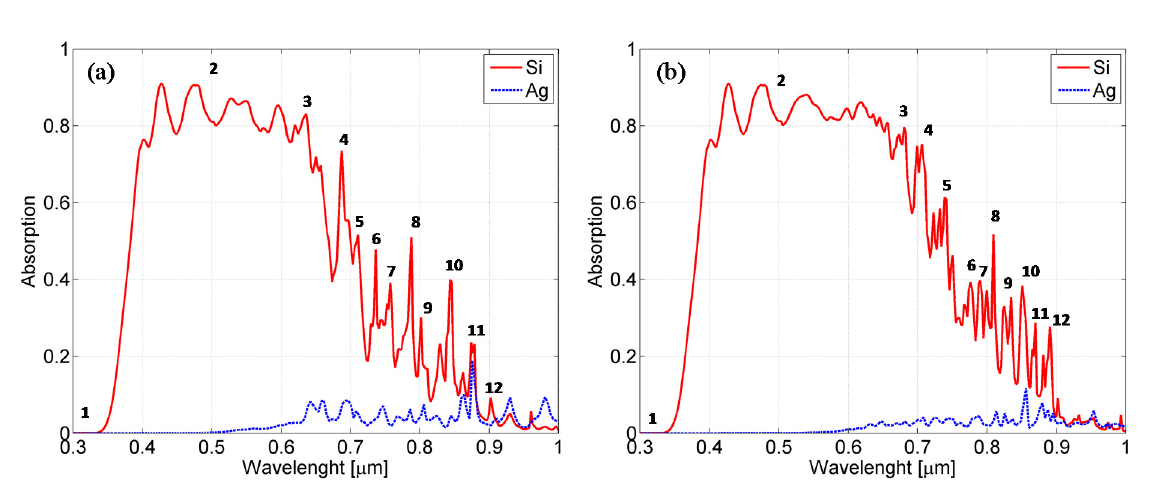
Figure 13. Absorption spectra evaluated over the silicon (solid lines) and into the silver (dotted lines) for the cells with silicon layer thicknesses of 800 nm ( a ) and 1500 nm ( b